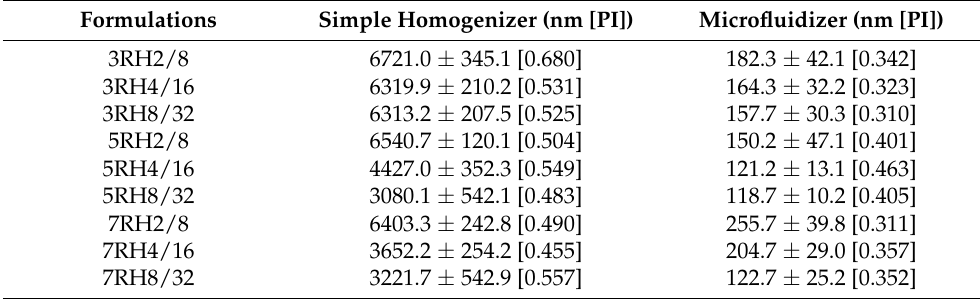
Table 2. Emulsion droplet sizes after passing though the simple homogenizer and microfluidizer ( n = 3).